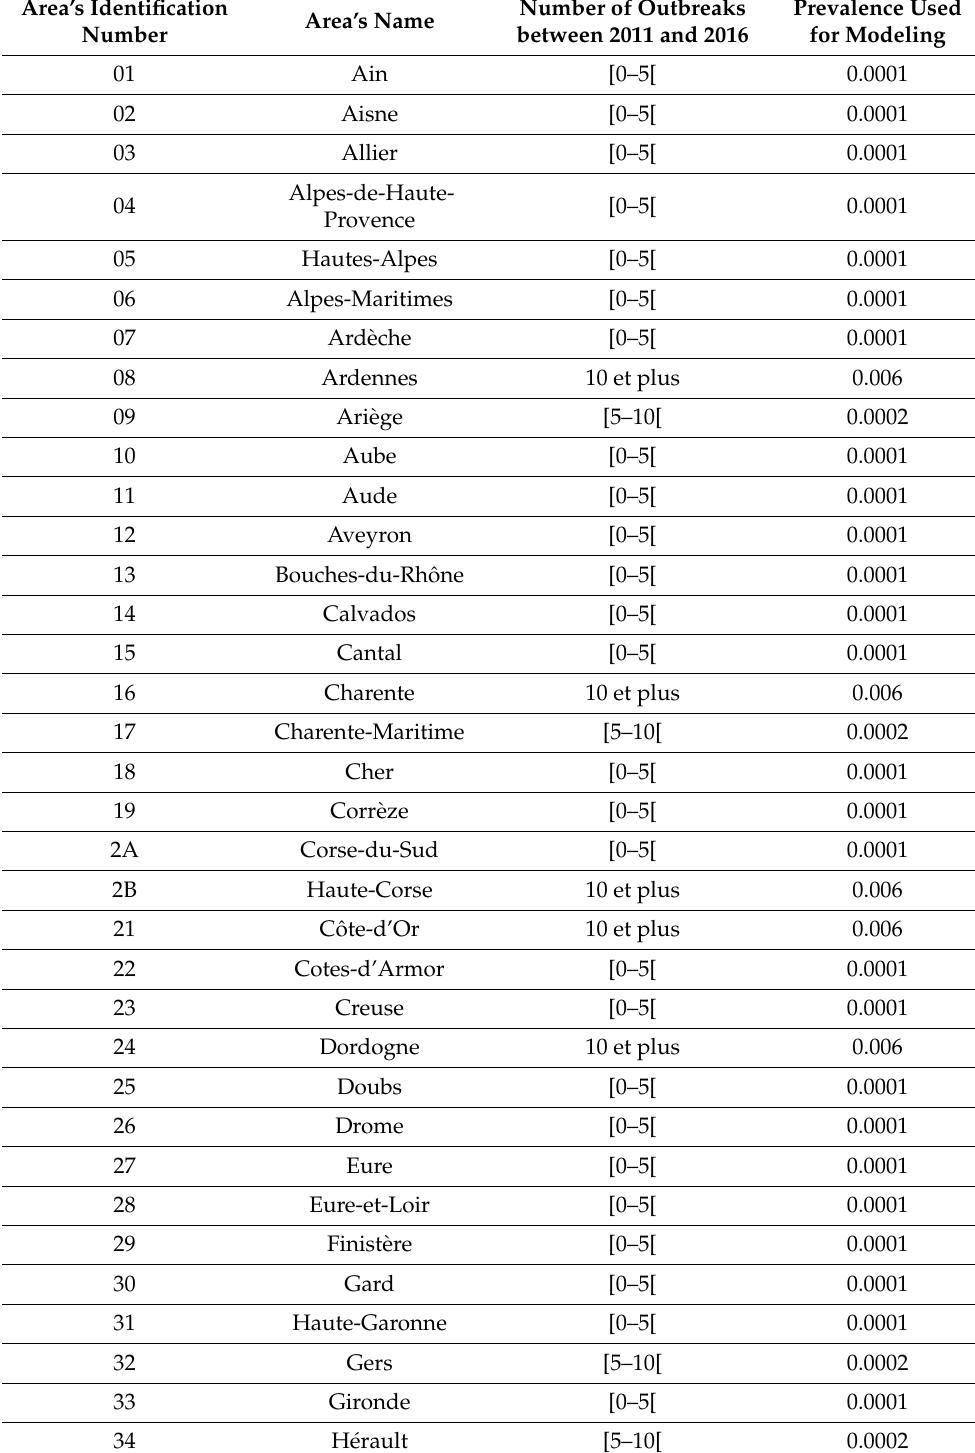
Table A1. Details of the prevalence set in each area for the evaluation of the TB ante-mortem surveillance